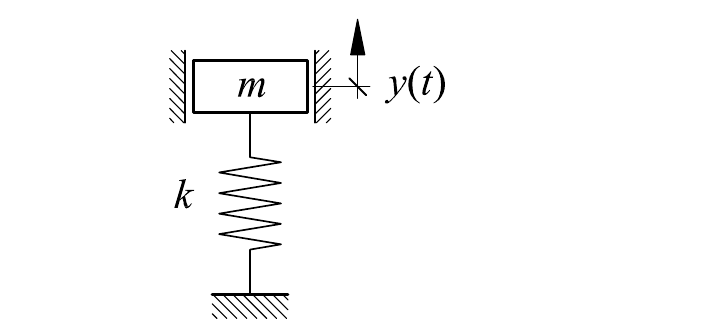
Figure 4. Oscillator of parameters k and m as the substitute system for the reinforced concrete